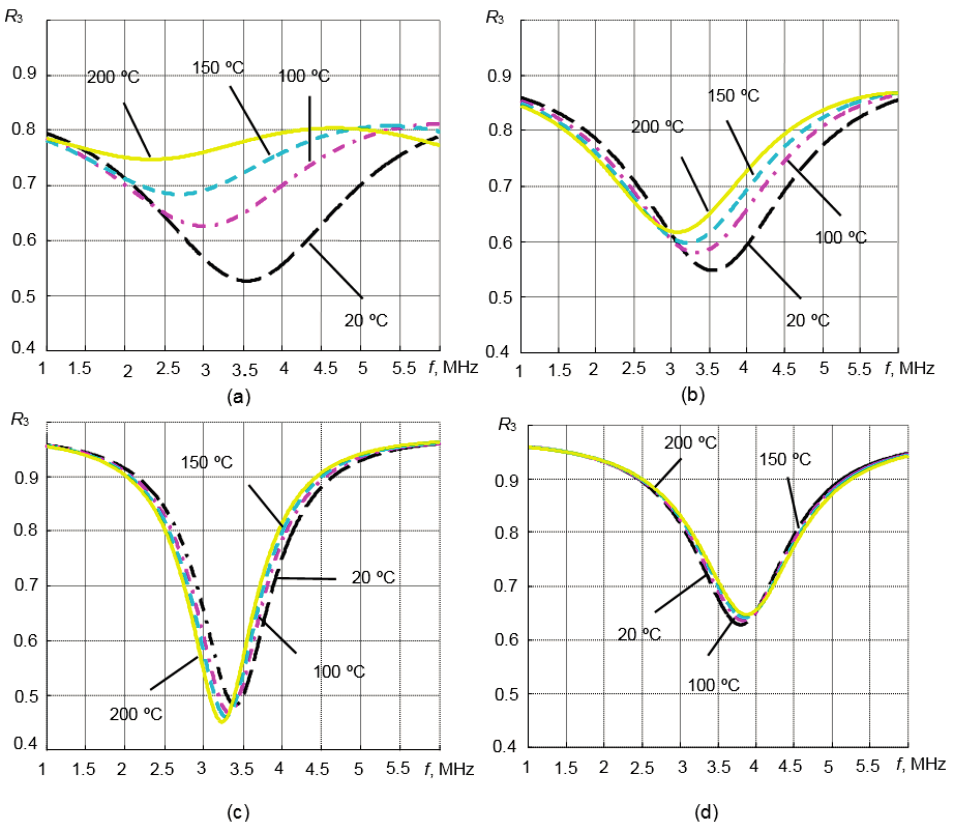
Figure 8. The reflection coefficient R 3 from the tip of the waveguide with the λ /4 matching layer versus that of a frequency at different temperatures. ( a ) Titanium waveguide with the Duralco matching layer; ( b ) titanium waveguide with the PBI matching layer; ( c ) steel waveguide with the glass enamel matching layer; ( d ) steel waveguide with the aluminum powder matching